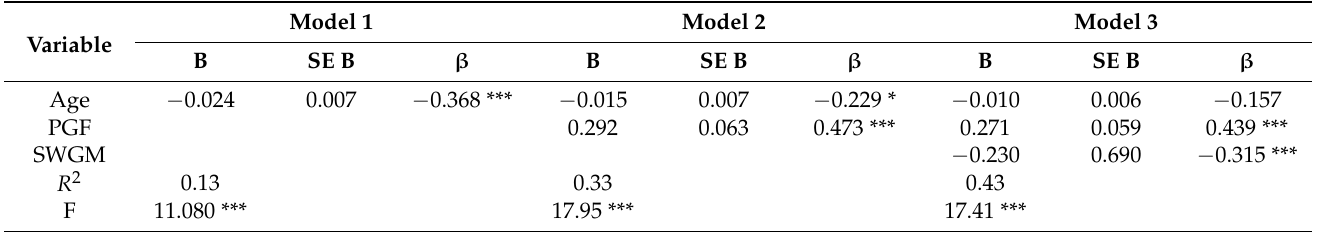
Table 4. Stepwise regression of the CF feature prediction by handwriting process measures, PGF ability, and BDI scores above